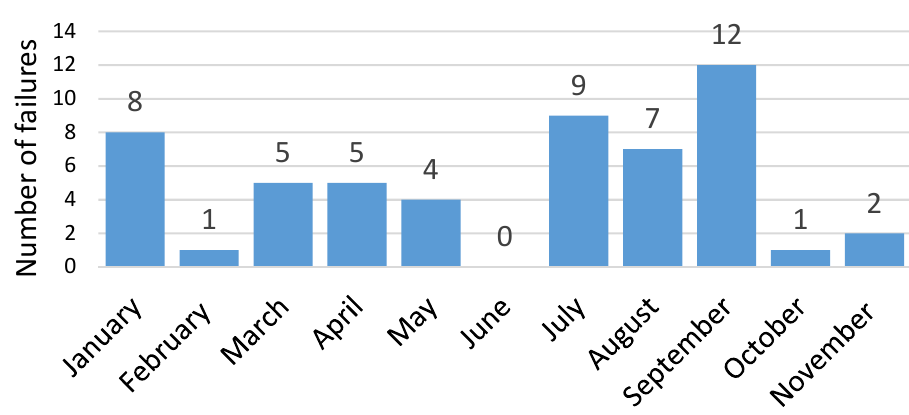
Figure 2. Distribution of failures in 2020 in the SVAN22LY1 power grid, logged in the FASIT report of Troms Kraft .